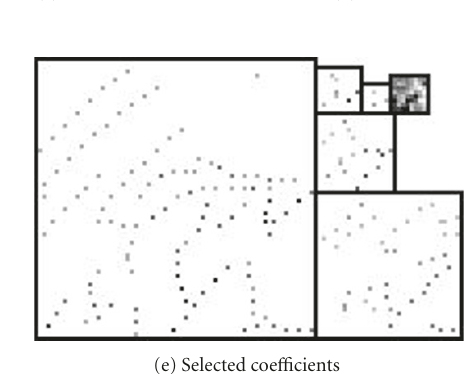
Figure 8: Compression of “Lena” at 0 . 93bpp. (a) 64 × 64 original image. (b) In the JPEG-compressed image most of the contours and textures disappeared while block artifacts are salient. (c) Many de- tails of the JPEG-2000 image are smoothed, in particular the strips and hairs of the hat. Moreover artifacts appear specially on diagonal edges. (d) In the image compressed through sparse approximation, the disappearance of visual details does not yield high frequency ar- tifacts. (e) Selected subdictionary (here 2 every 3 coe ffi cients have been zeroed along chains as proposed in Section